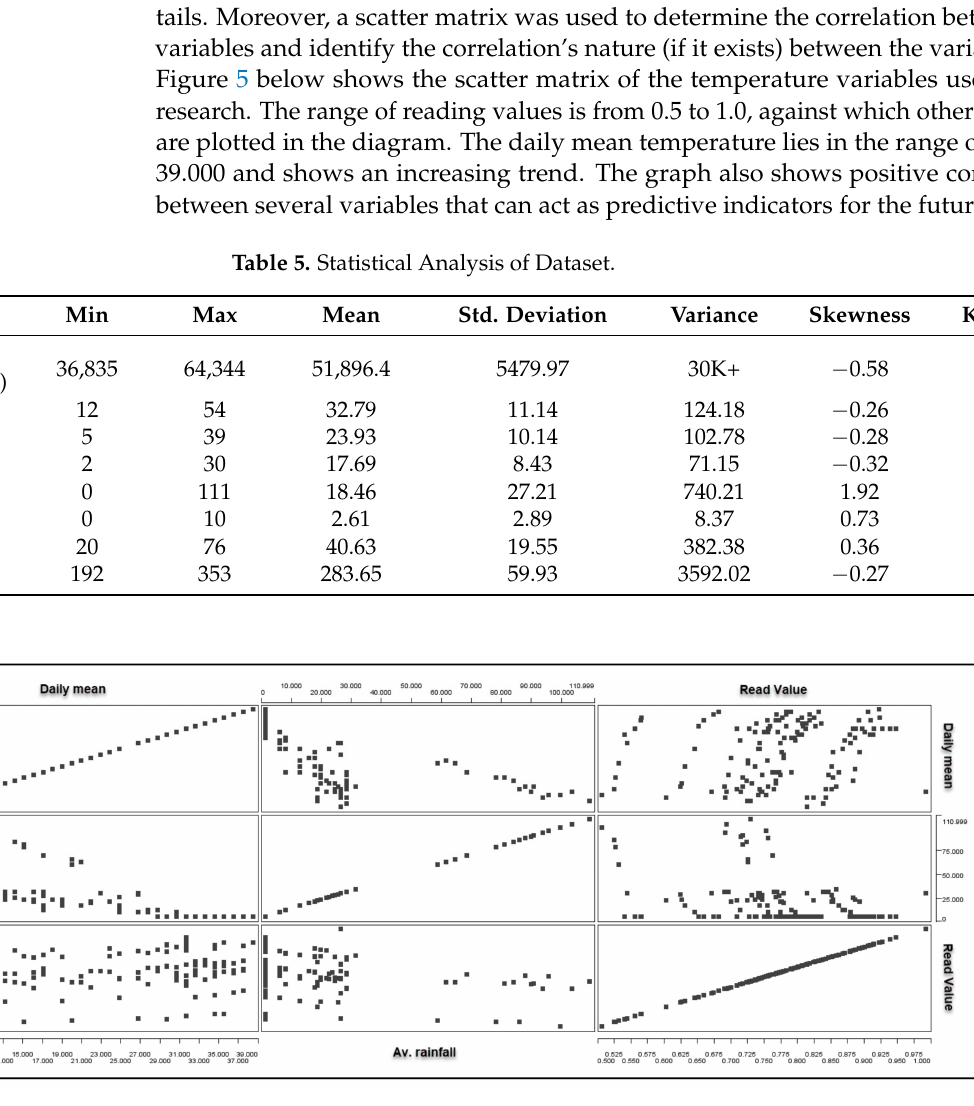
Figure 5. Scatter Matrix as Visual